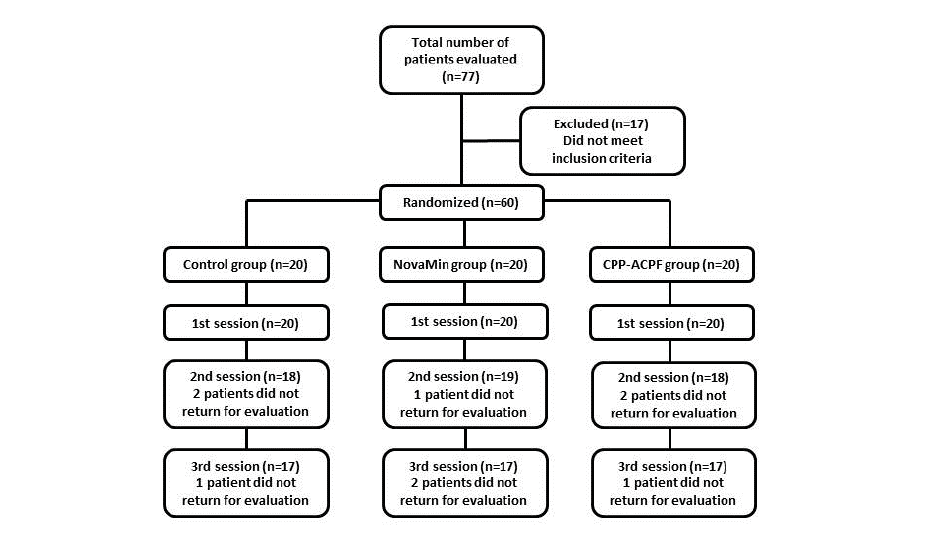
Figure 2- Schematic study Table 1- Median (Md) and interquartile ranges (IQR) of sensitivity described by patients after bleaching treatment, according to experimental group and session